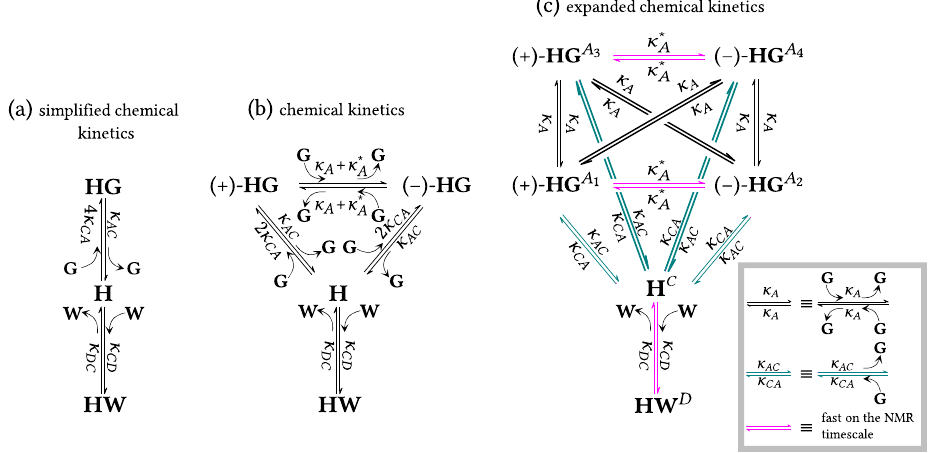
Figure 8. Chemical kinetics schemes for the multi-state system of di-bromobenzylated oxoporphyrinogen (host H ) in the presence of two ligands, ( R )-camphorsulfonic acid (ligand G ) and water (ligand W ). ( a ) Simplified chemical kinetics scheme corresponding to 1:1 H : G binding with competitive 1:1 H : W binding (see Section S11.3 in SI for details). ( b ) Chemical kinetics scheme describing interconversion of all distinguishable chemical species. ( c ) Expanded chemical kinetics scheme, equal to the full spin kinetics scheme. All relevant molecular processes and their reaction rate coefficients are shown. Processes denoted by magenta arrows are fast on the NMR